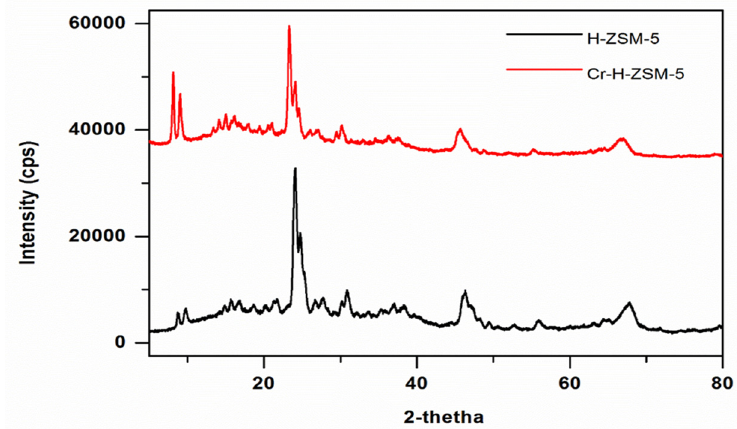
Figure 2. XRD pattern of H-ZSM-5 and Cr/H-ZSM-5 catalysts.